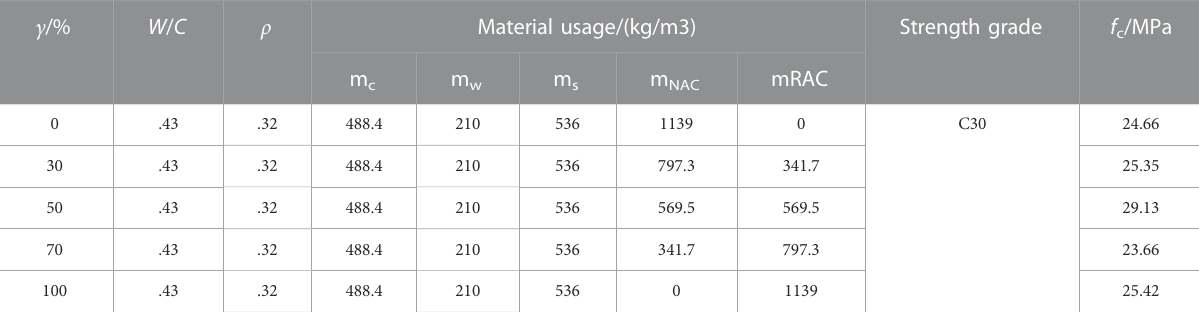
TABLE 3 Concrete